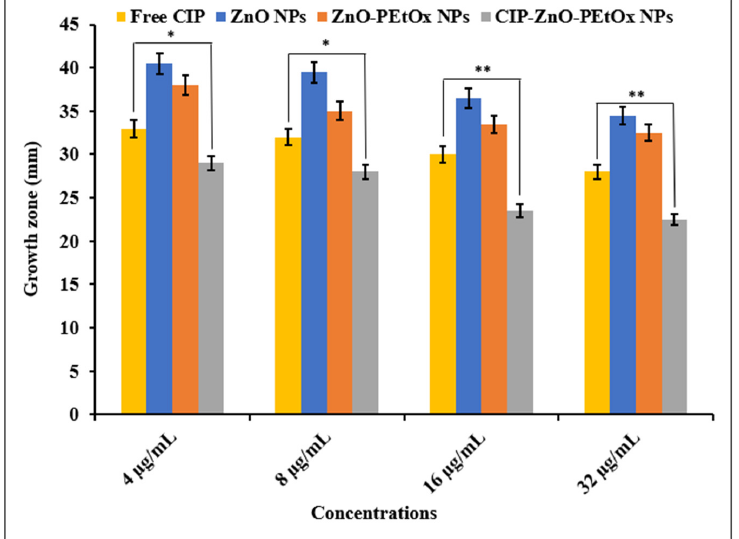
Figure 4. Bactericidal effects of free CIP, ZnO NPs, ZnO-PEtOx NPs, and combination of CIP-ZnO- loaded PEtOx NPs against P. aeruginosa . p > 0.05 (*), p < 0.05 (**).